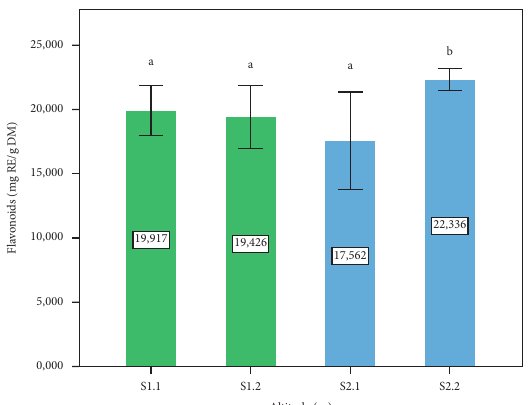
Figure 3: Flavonoid content of the P. lentiscus L. leaves at different altitudes. Data are means of three replicates. Vertical bars represent the standard deviation of the mean. Values not sharing a common letter indicate a significant difference at p ≤ 0 . 05, based on the SNK test. RE: rutin equivalent. DM: dry matter. S: site, S1.1 � 1400m, S1.2 � 1120, S2.1 � 780 m, S2.2 � 720m.